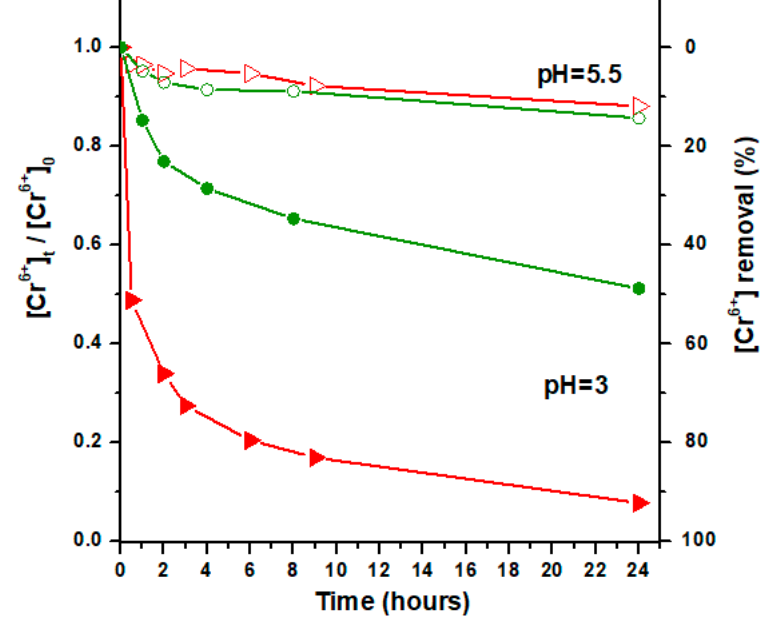
Figure 6. Effect of initial pH value (5.5 and 3) on the Cr (VI) removal efficiency by C-GLOVE ( ) and CMK-3 ( ).